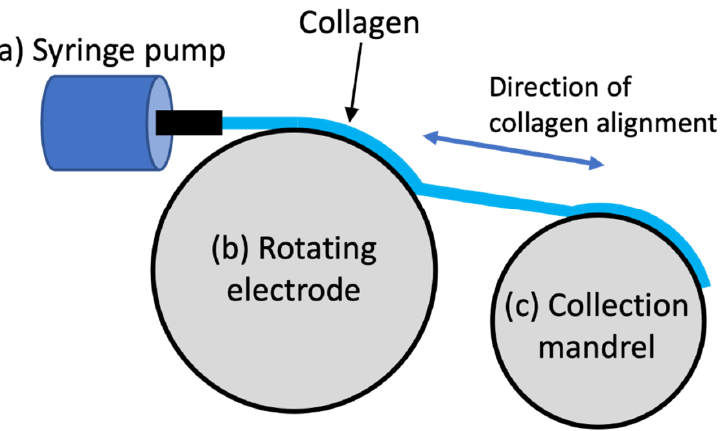
Figure 5. Schematic of rotating electrode electro-chemical alignment device (REEAD) for continuous electro-compaction of threads, ( a ) syringe pump, ( b ) rotating wheel with electrodes on the edge and collagen between, and ( c ) rotating collection mandrel.